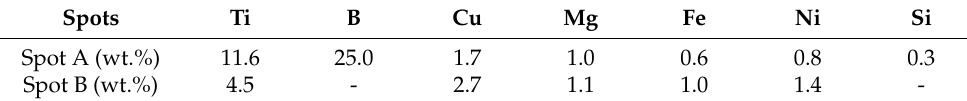
Table 3. EDS analysis of the spots labelled as A and B in the micrograph of Figure 2c.